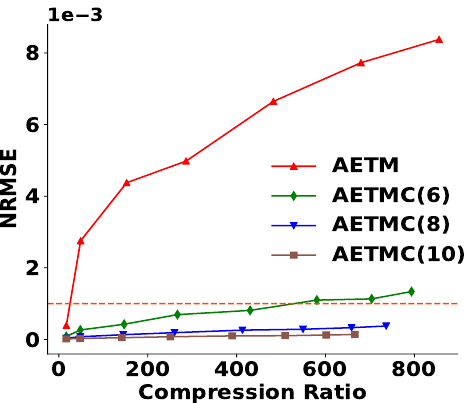
Figure 4. Average of six QoI errors after constraint satisfaction. Table 3. Primary data error increase after constraint satisfaction. The numbers in the parentheses here and in Figure 4 are the quantization bits for Lagrange multipliers. Framework PD Error Increase ( % )